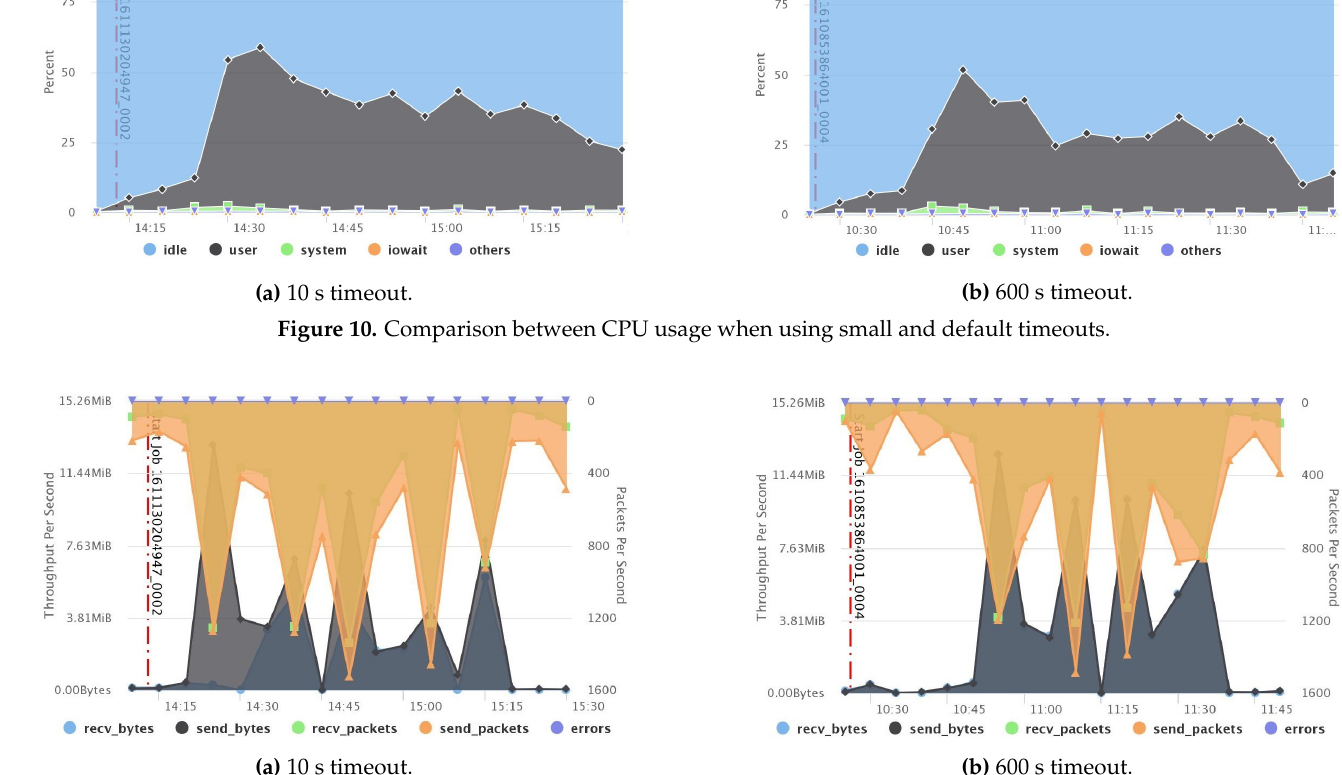
Figure 11. Comparison between network usage when using small and default